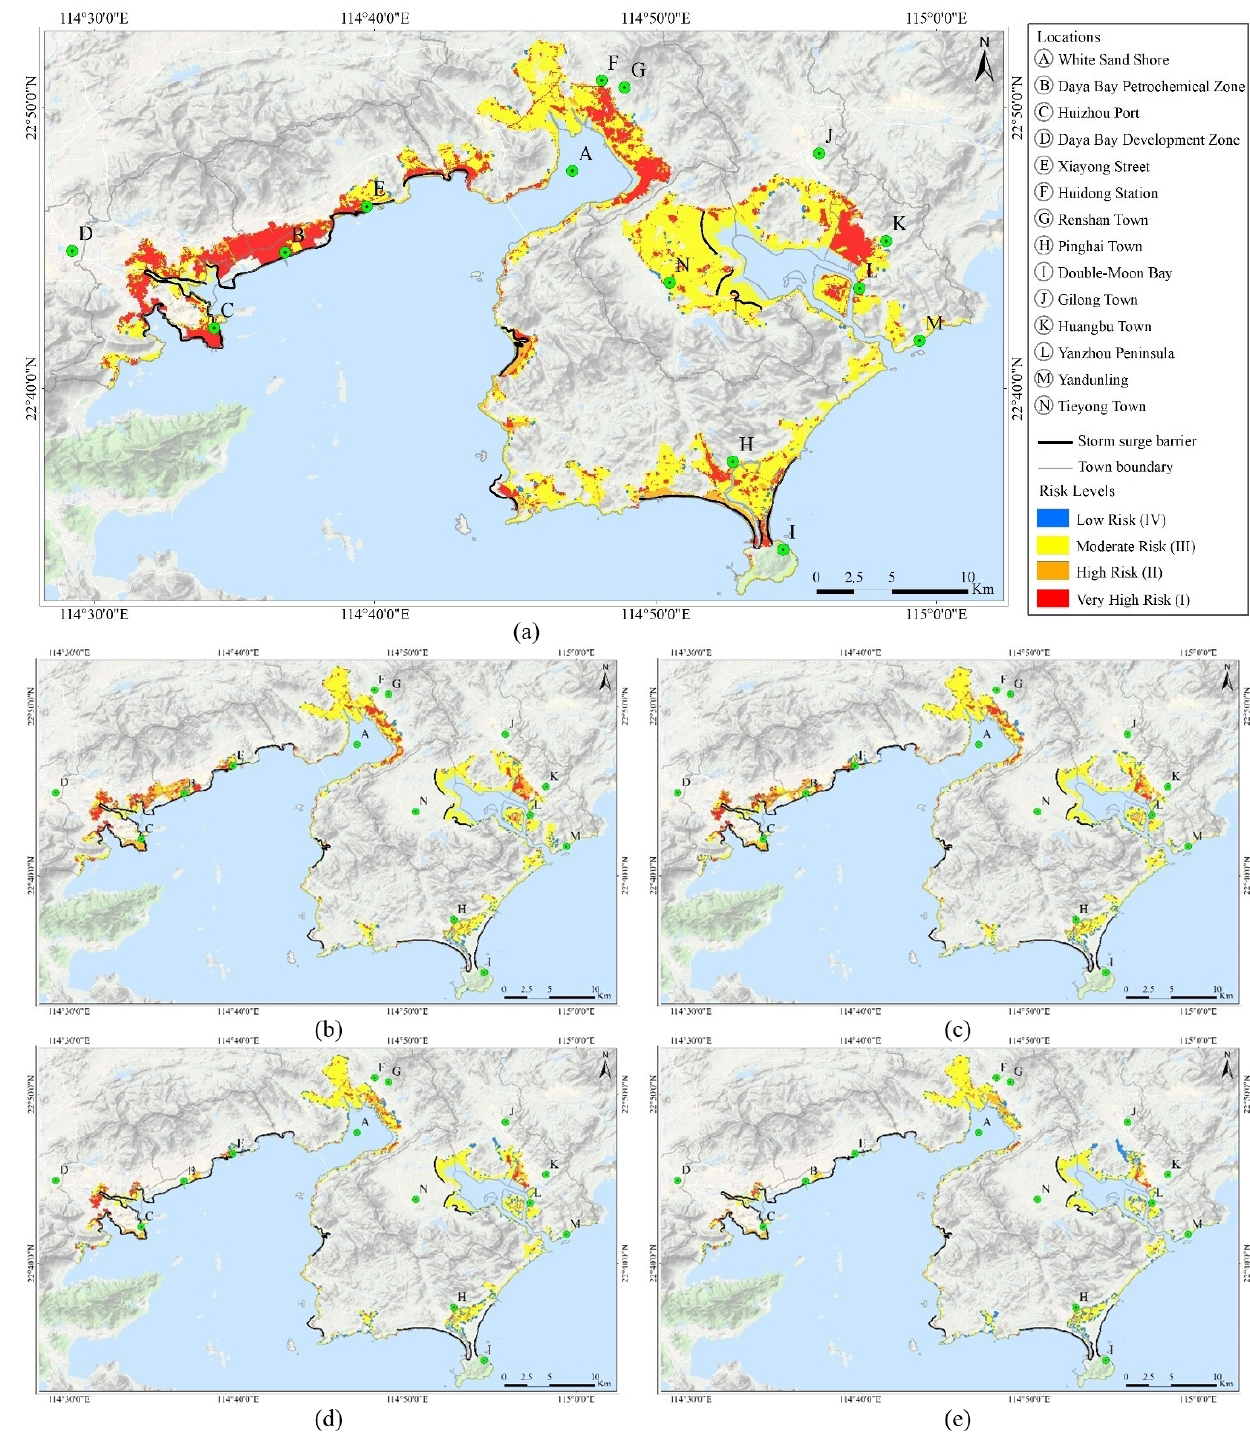
Figure 19. The risk assessment maps represent the potential risk of storm surge for five designed storm scenarios: (a) 880hPa, (b) 910hPa, (c) 920hPa, (d) 930hPa, (e) 940hPa. Different colors represent different risk levels. The red means the very high risk, orange stands for high risk, yellow represents moderate risk, and blue indicates low risk on the map. The important locations in the study area are labeled with letters, and the violet lines refer to the storm surge barriers along the coastline of Huizhou. These maps were made using the ArcGIS 10.5 software based on the terrain base map layer, which was obtained from © Google Maps (map data © 2019 Google).